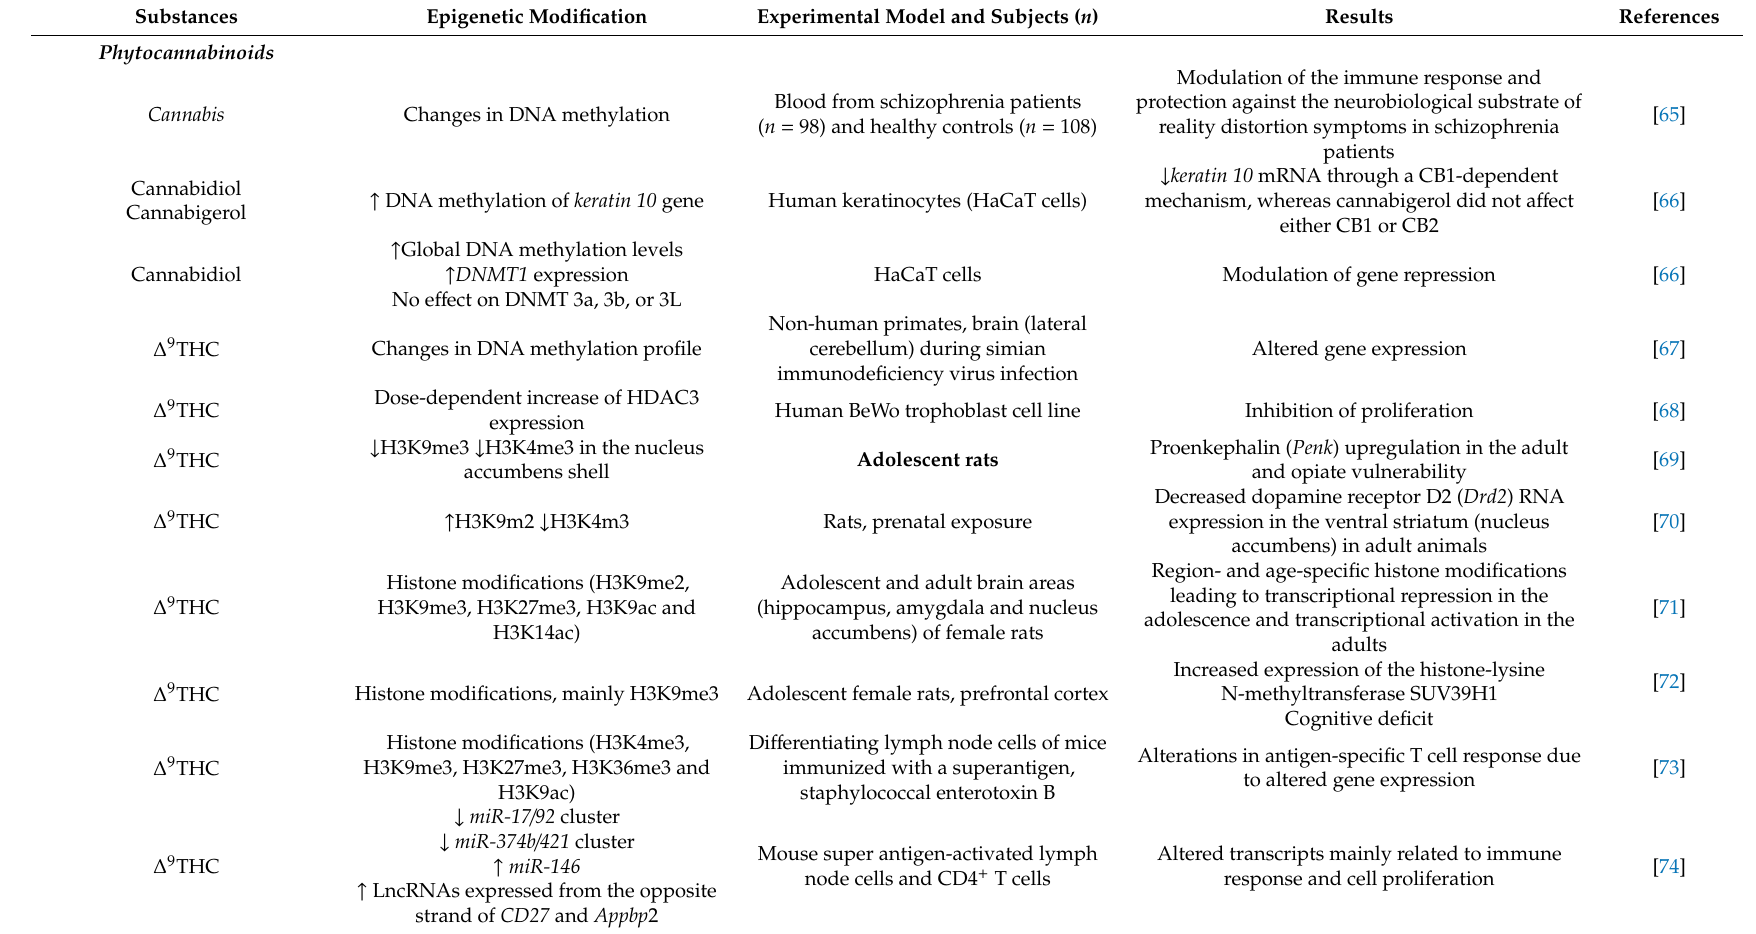
Table 2. Epigenetic changes induced by phytocannabinoids, endocannabinoids, and ES agonists /